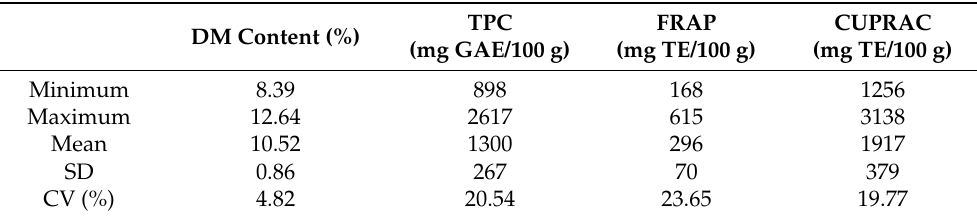
Table 2. Range, mean standard deviation, and coefficient of variation for the DM, TP, FRAP, and CUPRAC datasets.